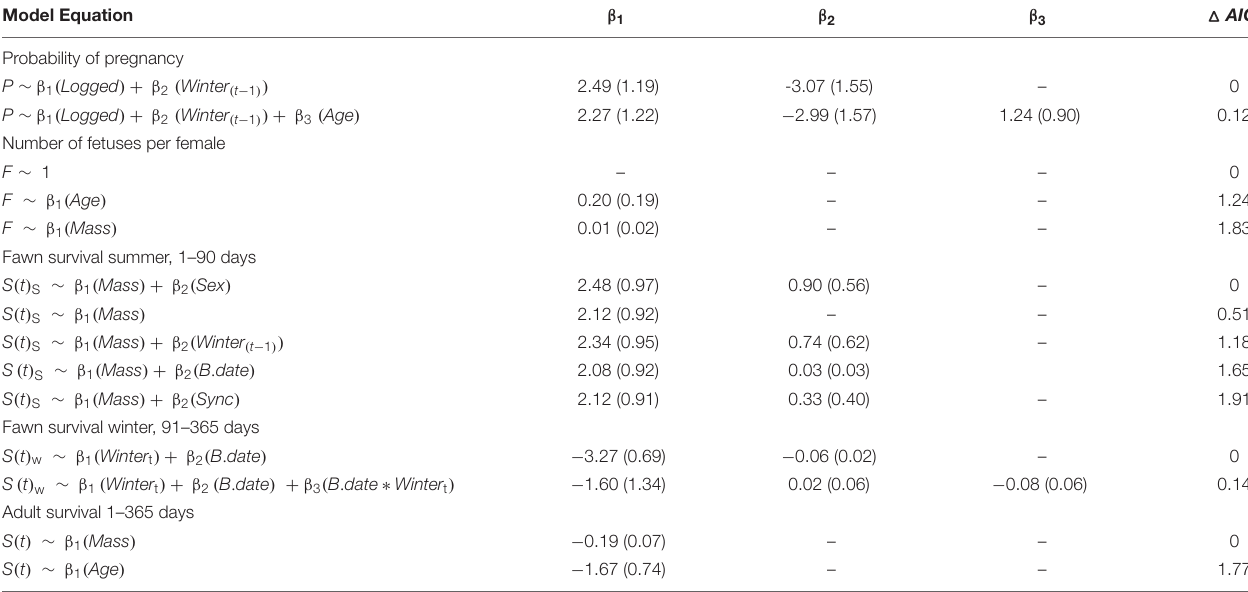
TABLE 3 | Ranked vital rate models within 2 AICc units of the top models of vital rates for Sitka black-tailed deer during the period of the study (2010–2013), Prince of Wales Island, AK, United States. Model